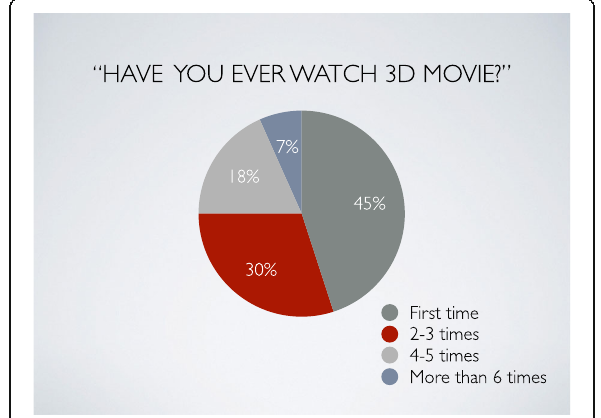
Fig. 4 Result 3. Many participants answered that the advantages of 3D movie were their appearance of solidity (63%) or realism (25%). An 8% of all answered it was their